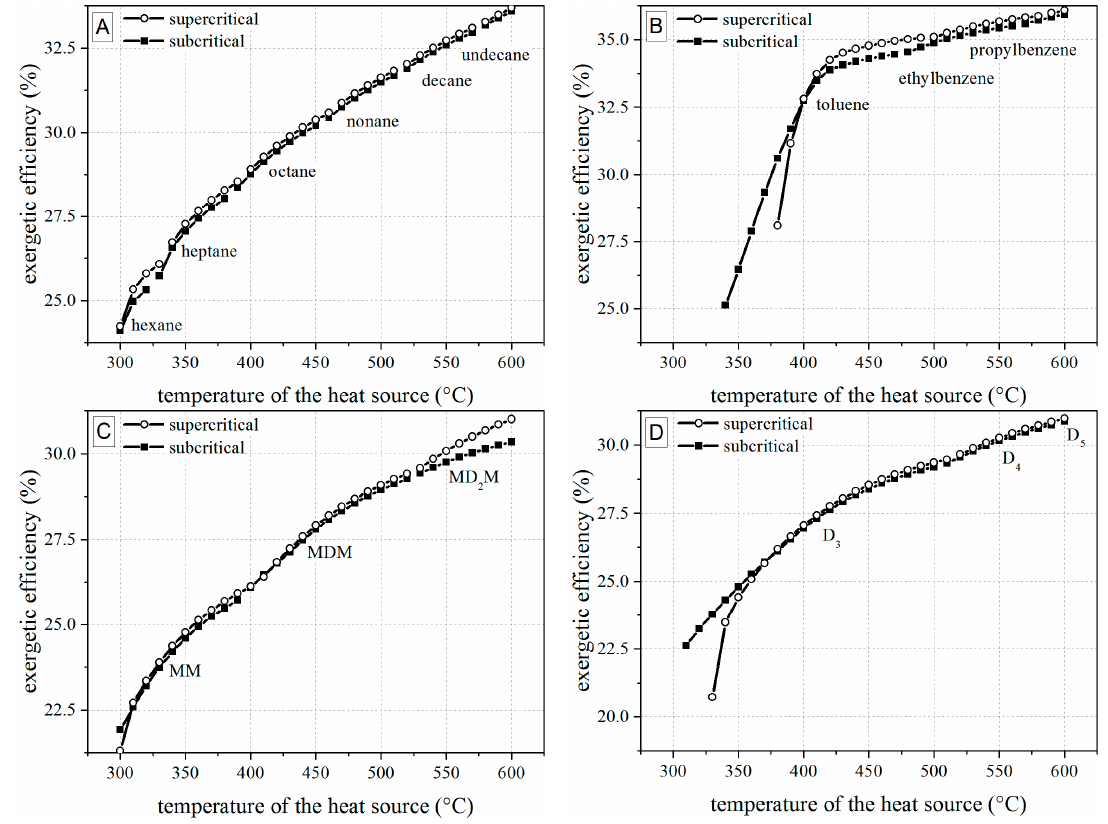
Figure 5. Exergetic efficiency for supercritical and subcritical mode of operation for varied heat source temperature (( A ) n -alkanes; ( B ) alkylbenzenes; ( C ) linear siloxanes; and ( D ) cyclic siloxanes).